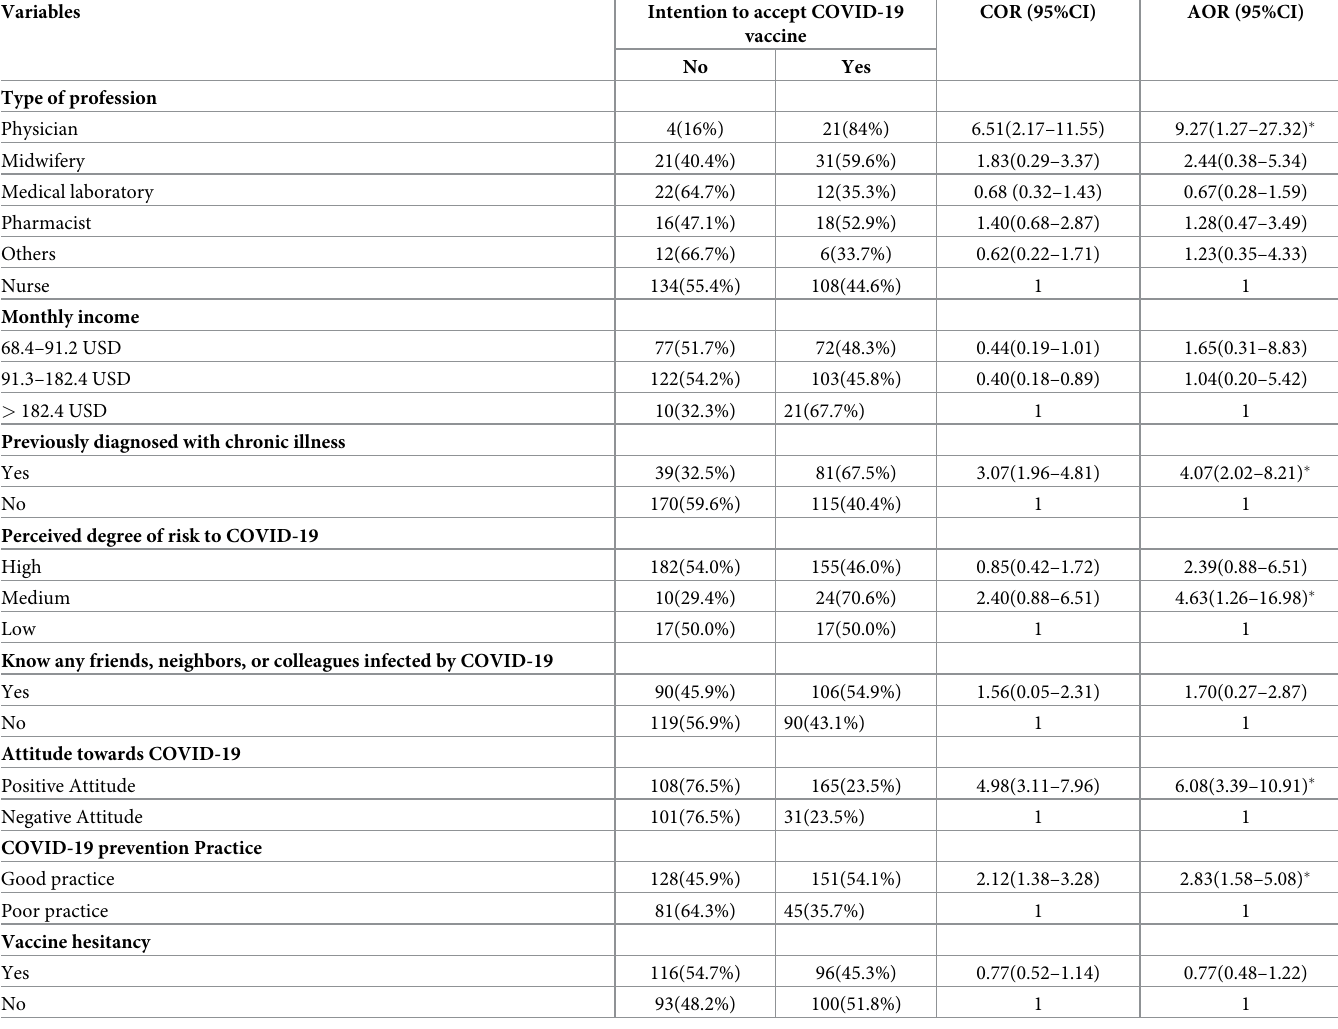
Table 7. Factors associated with health care workers intention to accept COVID-19 vaccine in southwestern Ethiopia,